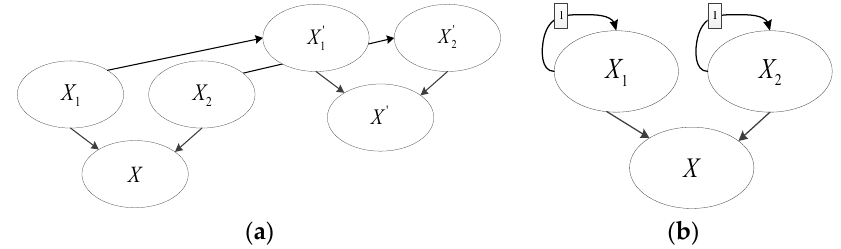
Figure 3. ( a ) A two-step DBN in the extended form. ( b ) The abstract form of the DBN. Where the nodes X 1 , and X 2 are the nodes in the original network; X 1 ’, X 2 ’, and X ’ reflect the state of the same node in the next time steps; the number 1 on the arced arrow represents the number of time steps used for the time dependencies.